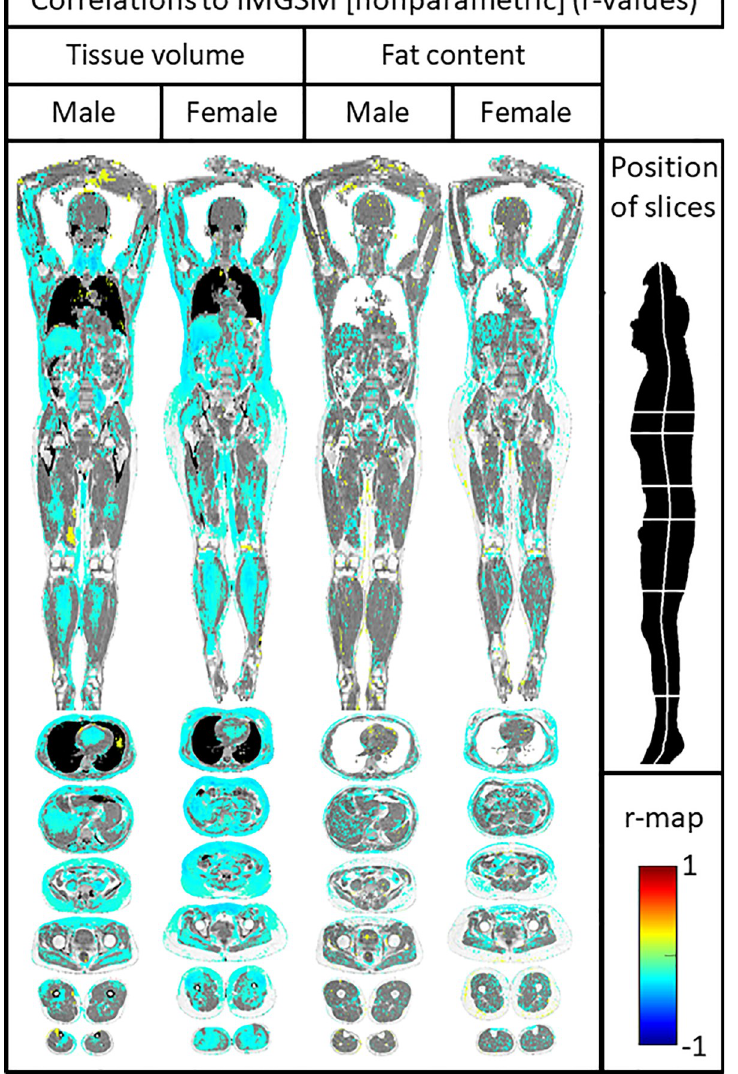
Fig 3. Imiomics correlation maps showing relations between tissue volume/fat content and the echogenicity of the intima-media (IM-GSM). Significant (P < 0.05) voxelwise non-parametric Spearman rank coefficient correlation values are shown in the colorscale in the lower right. Pixels with non-significant correlations show the underlying water signal values. One Coronal slice and six axial slices are shown, as given by the illustration in the upper right part of the